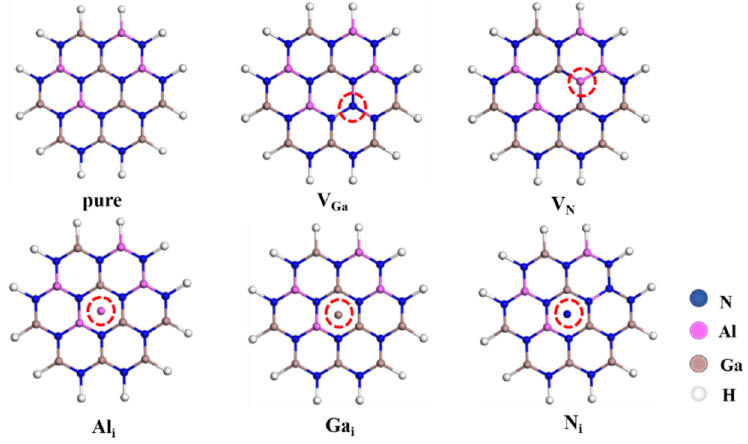
Figure 1. The top views of different defect structures. Pure: no defect; V Ga : Ga vacancy defect; V N : N vacancy defect; Al i : Al interstitial defect; Ga i : Ga interstitial defect; N i : N interstitial defect.